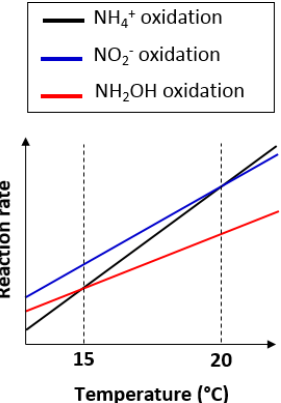
Figure 7. Graph of the difference in temperature dependency of the reactions involved in